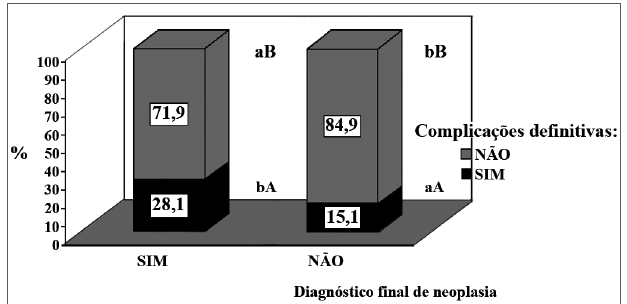
Figura 1. Distribuição percentual dos pacientes tireoidectomizados, quanto à presença de diagnóstico final de neoplasia maligna, em relação à ocorrência ou não de complicações cirúrgicas definitivas. A comparação dentro de cada grupo, com ou sem diagnóstico de neoplasia maligna, é representada pelas letras maiúsculas e a entre grupos, pelas minúsculas [teste de Goodman; b > a, B > A ( p < 0,05)].